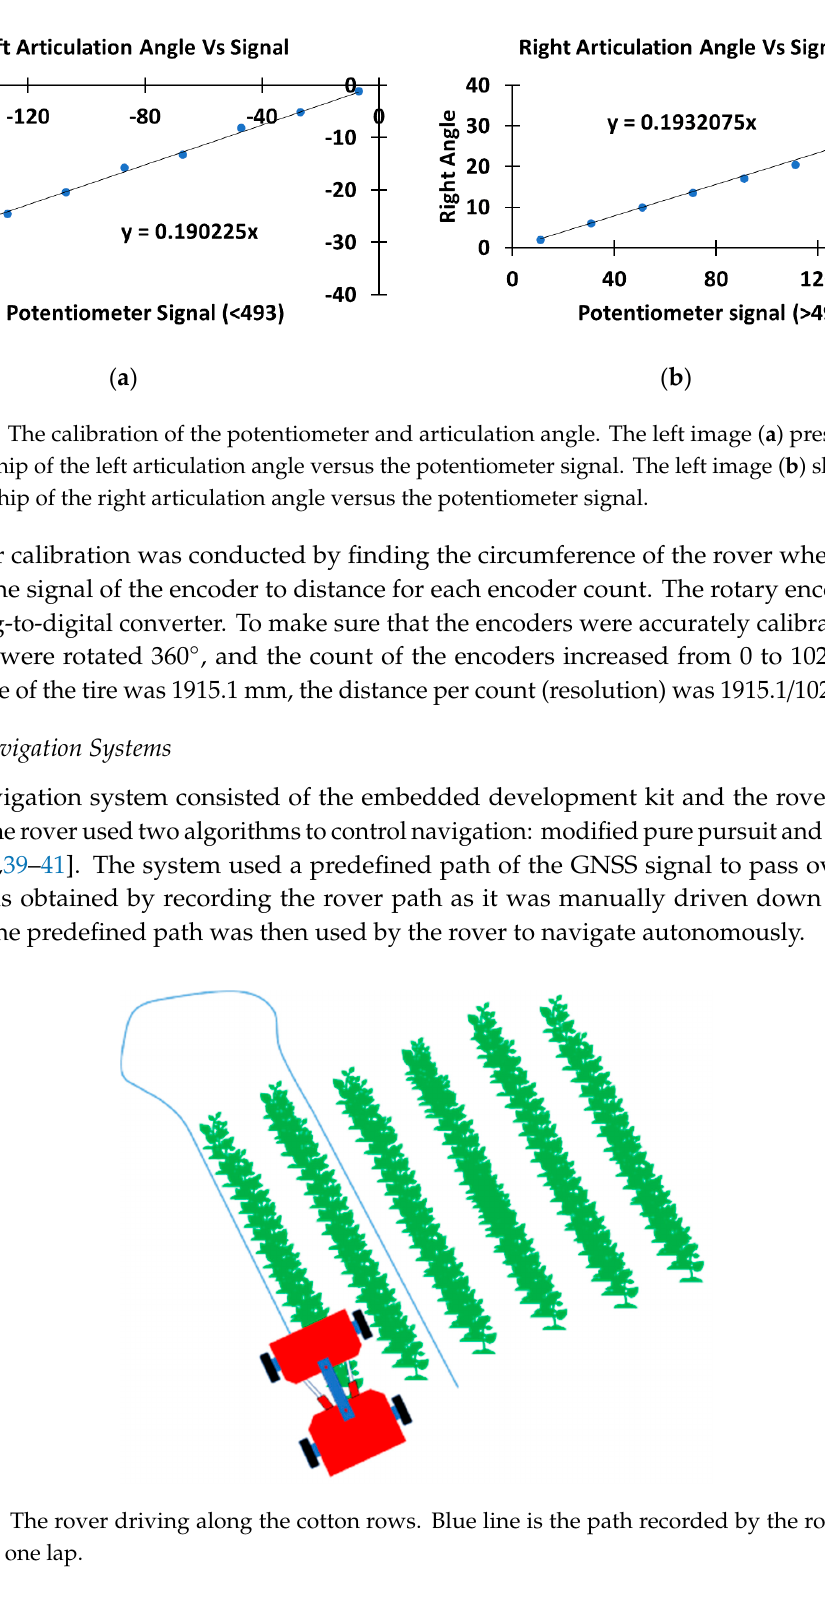
Figure 6. The rover driving along the cotton rows. Blue line is the path recorded by the rover after finishing one